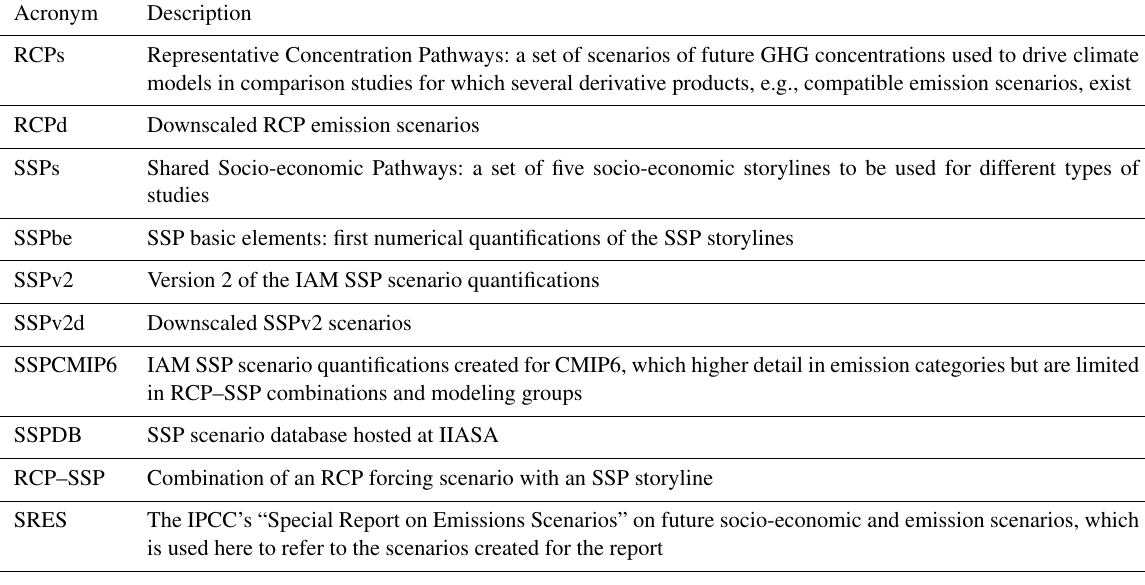
Table A3. RCP–SSP-related acronyms.